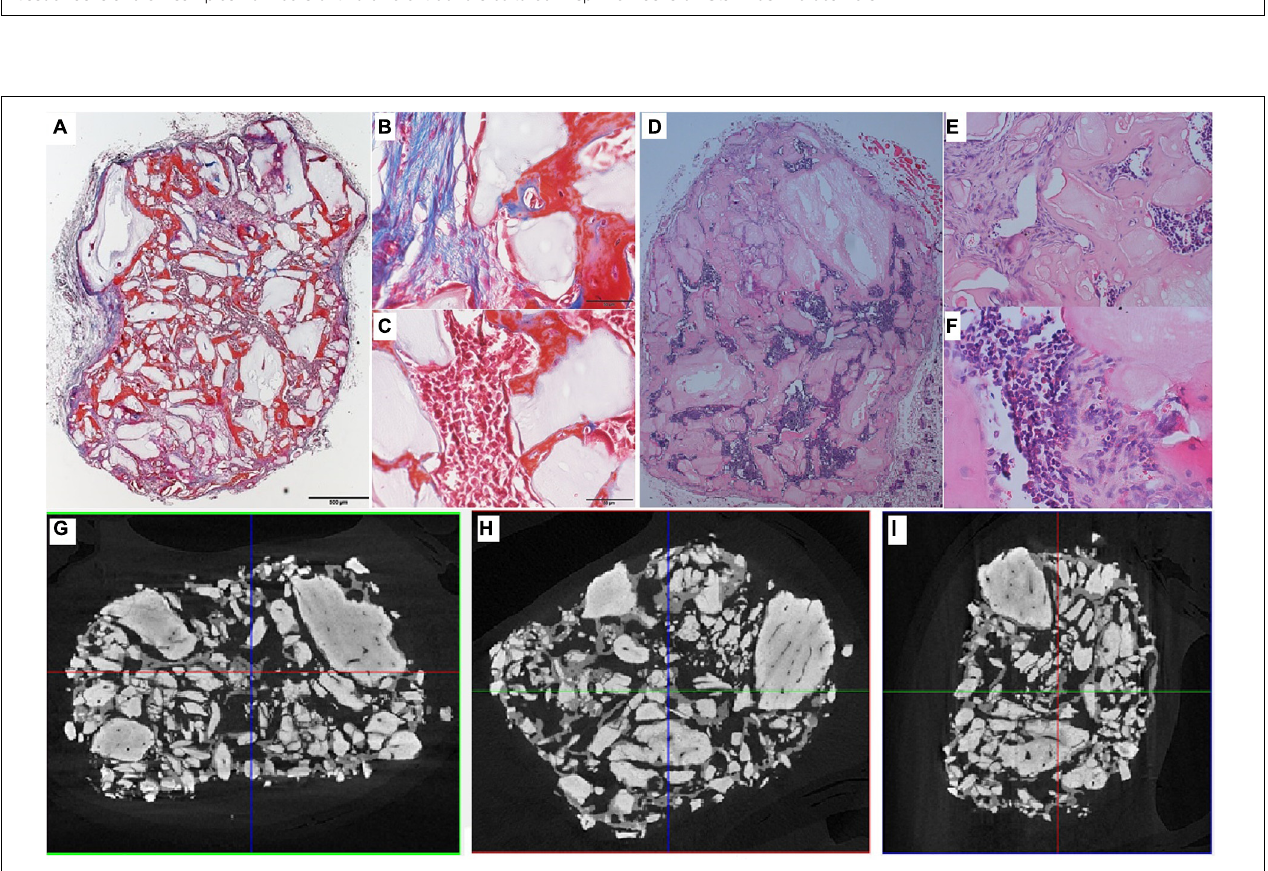
FIGURE 12 | Visualization of explant donor1 spinner flask1 results. (A–C) Masson’s Trichrome staining. (D–F) H&E staining. (G–I) nanoCT scans 2D sections in all 3 planes.